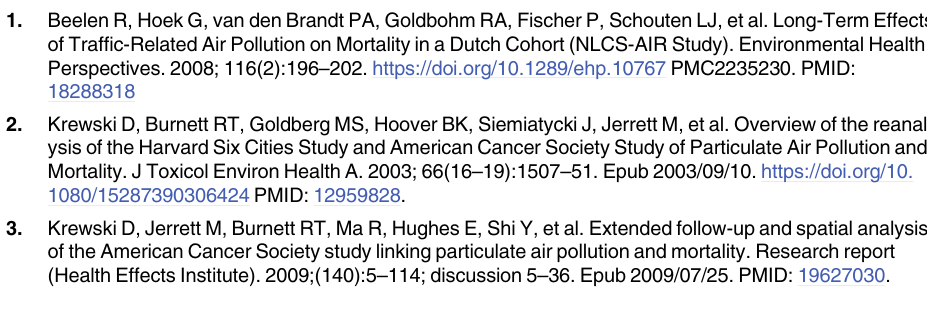
S1 Table. Forms of linear model fitted for number concentration and mass concentration for calibration. S2 Table. Summary of the R 2 , Bayesian Information Criterion (BIC), and the Normalized Mean Absolute Error (NMAE) of the calibration models for number concentration. S3 Table. Summary of the R 2 , Bayesian Information Criterion (BIC), and the Normalized Mean Absolute Error (NMAE) of the calibration models for mass